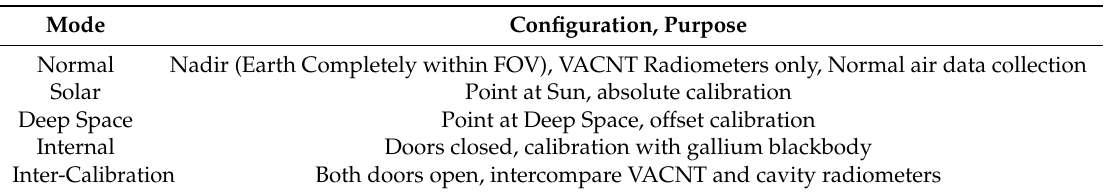
Table 23. Orbital Maneuvers Required for the RAVAN Payload [59].